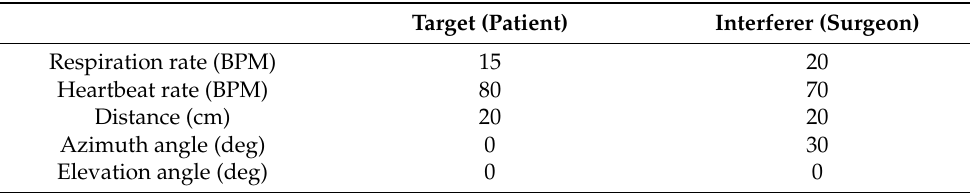
The target’s range and angle position were extracted by applying range-FFT along with beamforming. Figure 7 shows a heat map of the calculated results. The position of the target and interferer can be seen in the color of the heat map, indicating the signal power.